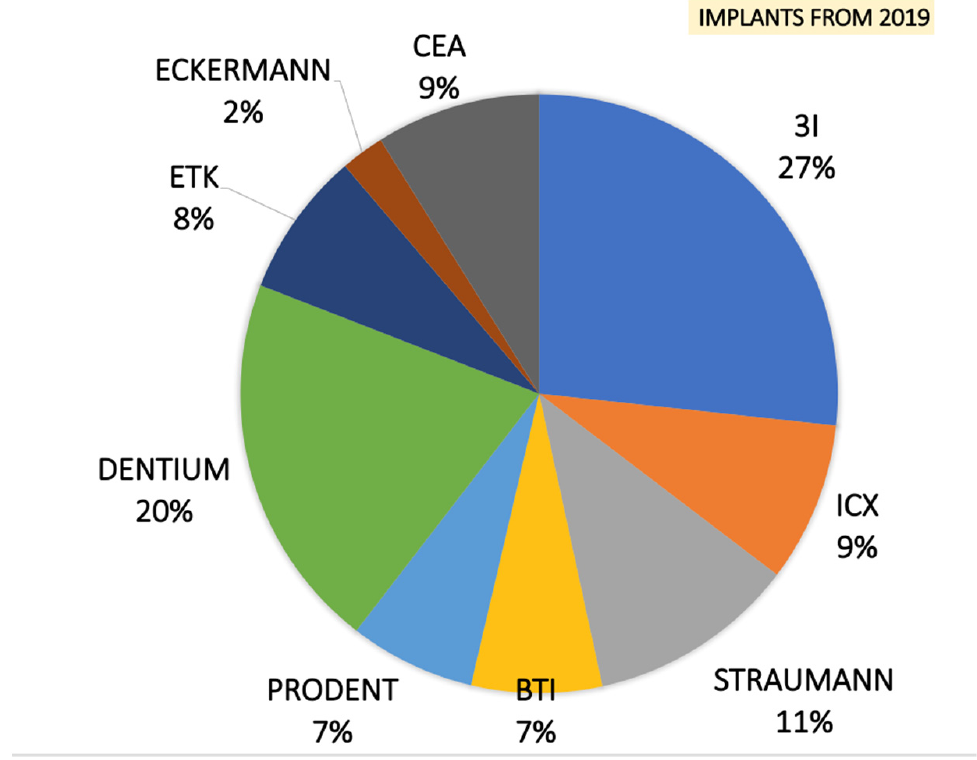
Figure 1. Four months after alveolar socket preservation procedures, a total of 483 dental implants were placed from 9 different dental implants systems.